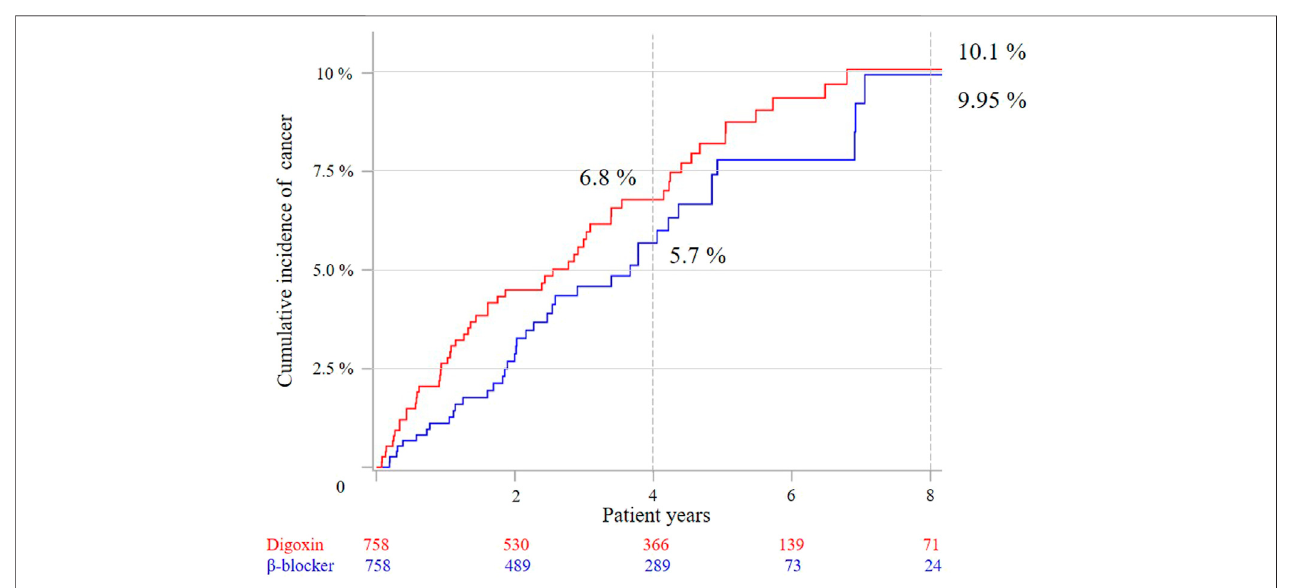
FIGURE 3 | Cumulative cancer incidence between the two groups after 1:1 propensity-score matching by competing risk analysis.